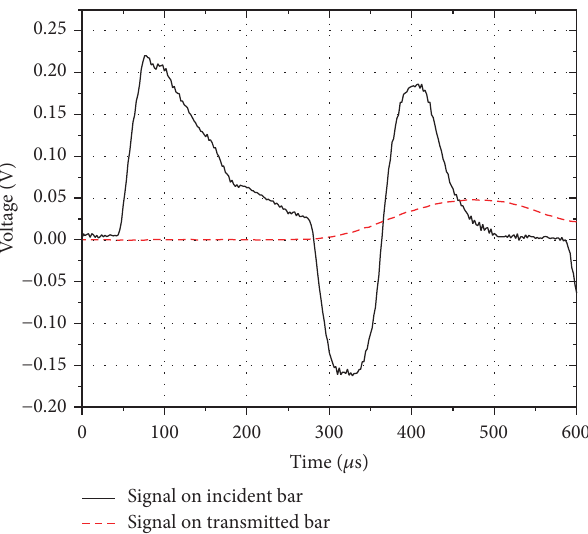
Figure 9: Original signals in a typical dynamic Brazilian test.